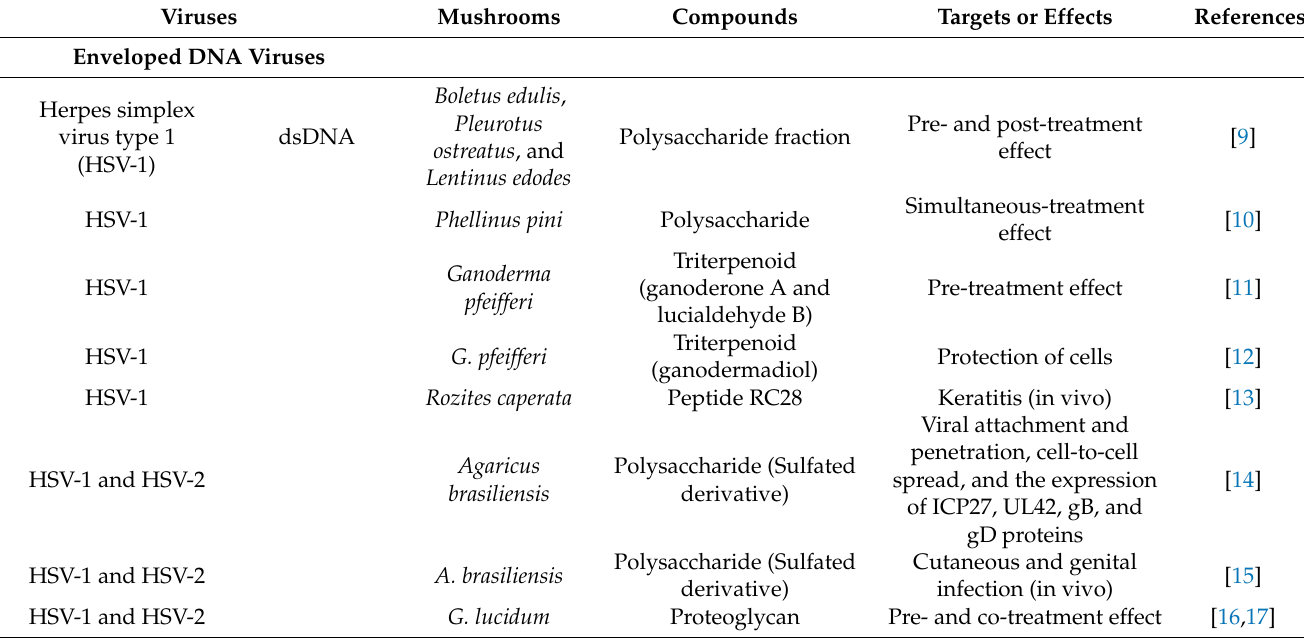
Table 1. Anti-herpes simplex virus compounds of mushrooms and their antiviral targets.